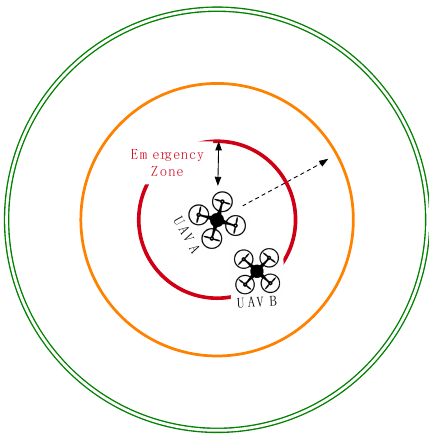
Figure 3. Case 2: stop movement for UAV B in the emergency zone.